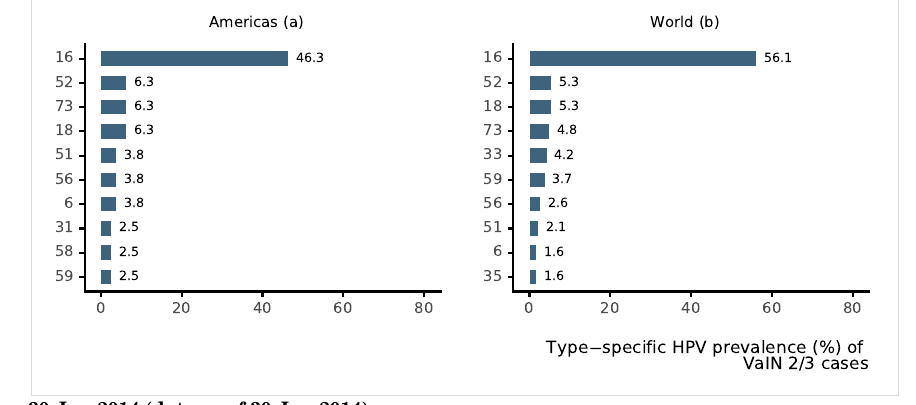
Figure 67: Comparison of the ten most frequent HPV types in VaIN 2/3 cases in Americas and the